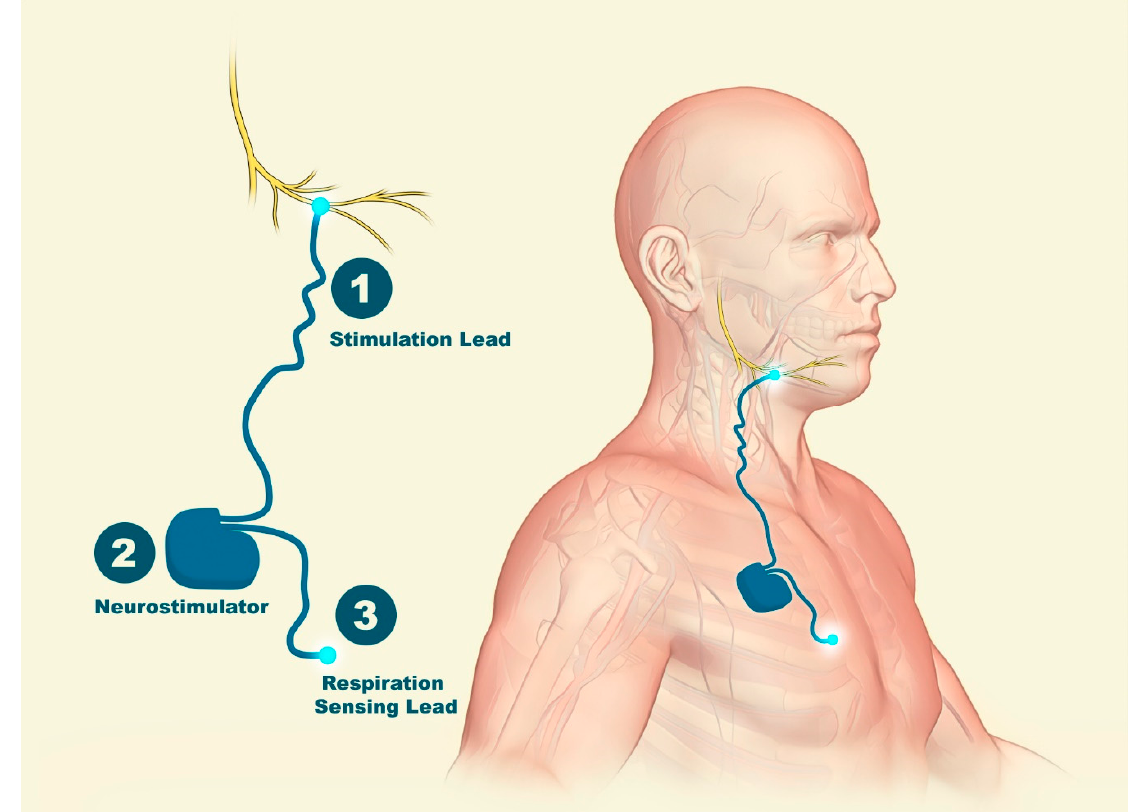
Figure 6 . Hypoglossal nerve stimulation devices. (1) An electrode cuff wrapped around the hypoglossal nerve attached to (2) an implantable pulse generator (IPG) surgically placed in a subcutaneous pocket; the IPG is attached to a respiration-sensing lead (3).